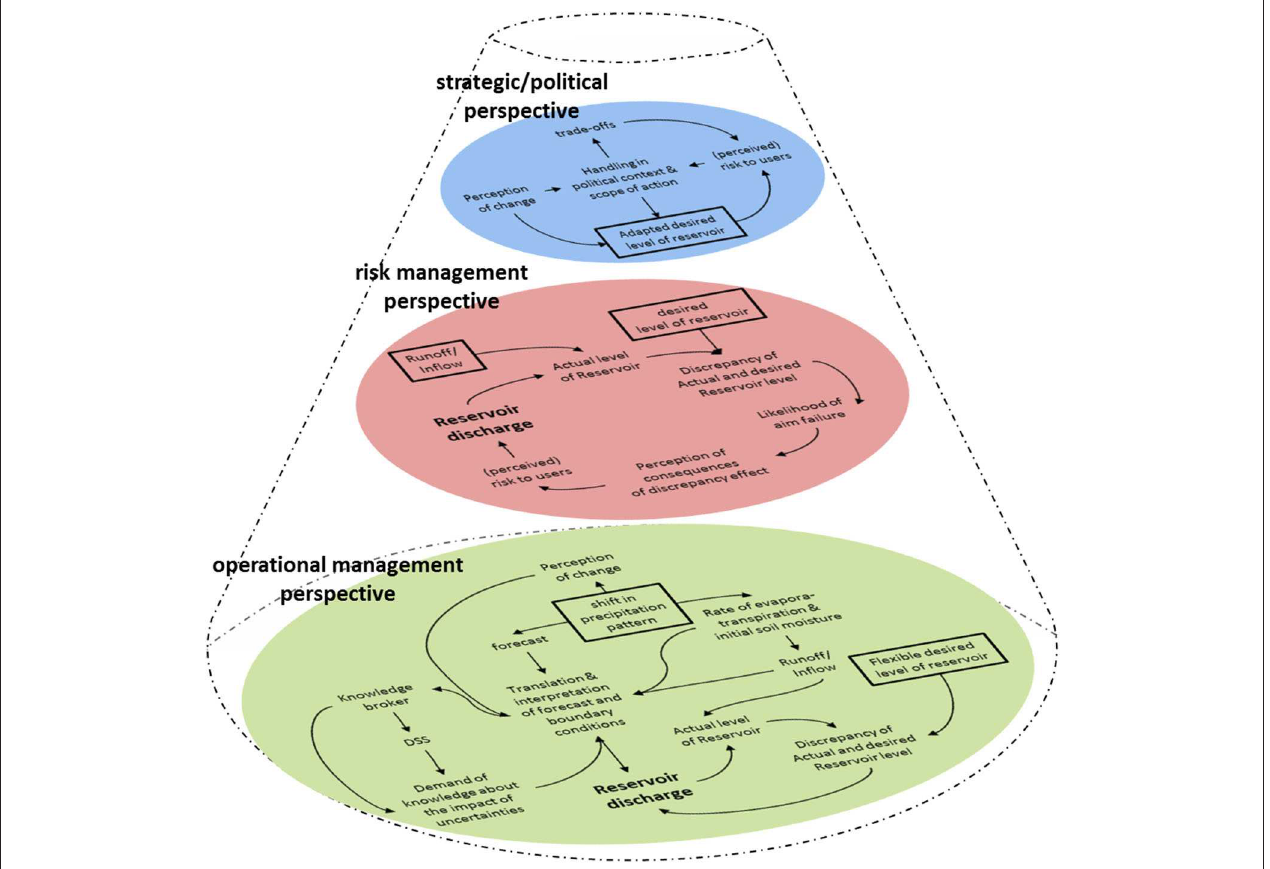
FIGURE 2 | Cone of influence diagram (CID) regarding reservoir discharge under changing precipitation patterns. The CID consists of three IDs representing the different perspectives on the problem narrative (green the operational management perspective, red the risk management perspective, blue the strategic/political perspective). The variables in boxes represent the physical and human-set boundary conditions, respectively. The latter boundary condition, the flexible, desired, and adapted desired level of reservoir also presents the conceptual consistency variable connecting the single IDs in the